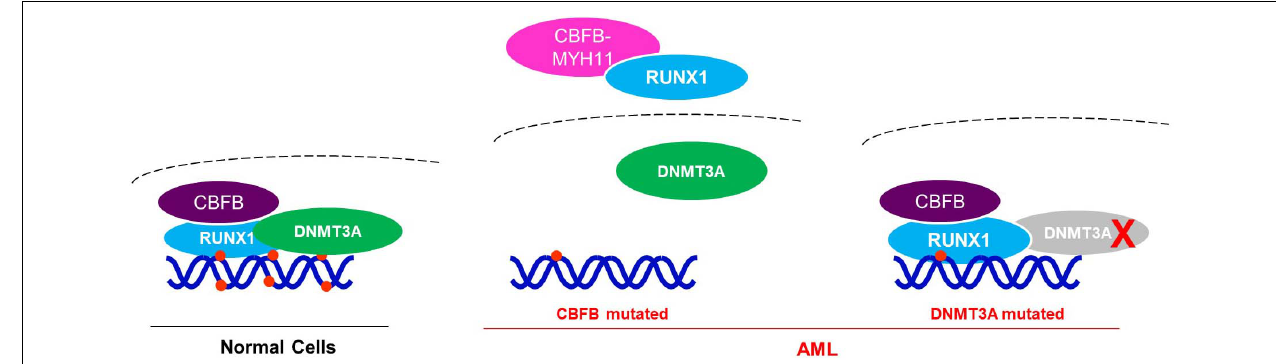
FIGURE 7 | Working model for the potential mechanism of CBFB-MYH11 in regulating RUNX1 target genes. In normal cells, DNMT3A is recruited by RUNX1/CBFB to methylate and suppress target genes. While in the CBFB-MYH11 mutant cells, RUNX1 is cytoplasmic and unable to recruit DNMT3A to target genes, leading to hypomethylation and upregulation of target genes. Alternatively, in tumor cells bearing DNMT3A catalytic mutant, the mutant DNMT3A fails to methylate RUNX1 target